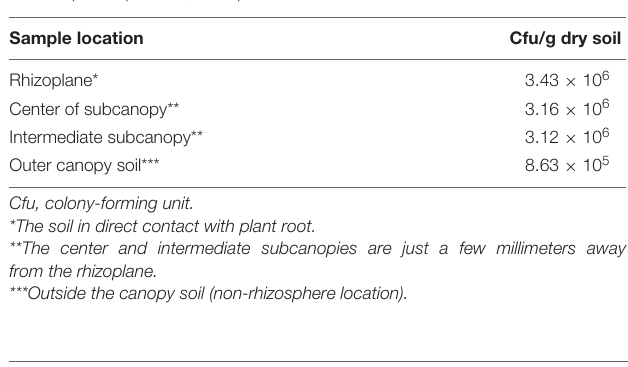
TABLE 3 | The number of bacterial colonies recorded from soil samples obtained from various locations at the rhizosphere and outer canopy soil of Ghaf ( Prosopis cineraria ) trees (Al-Thani,